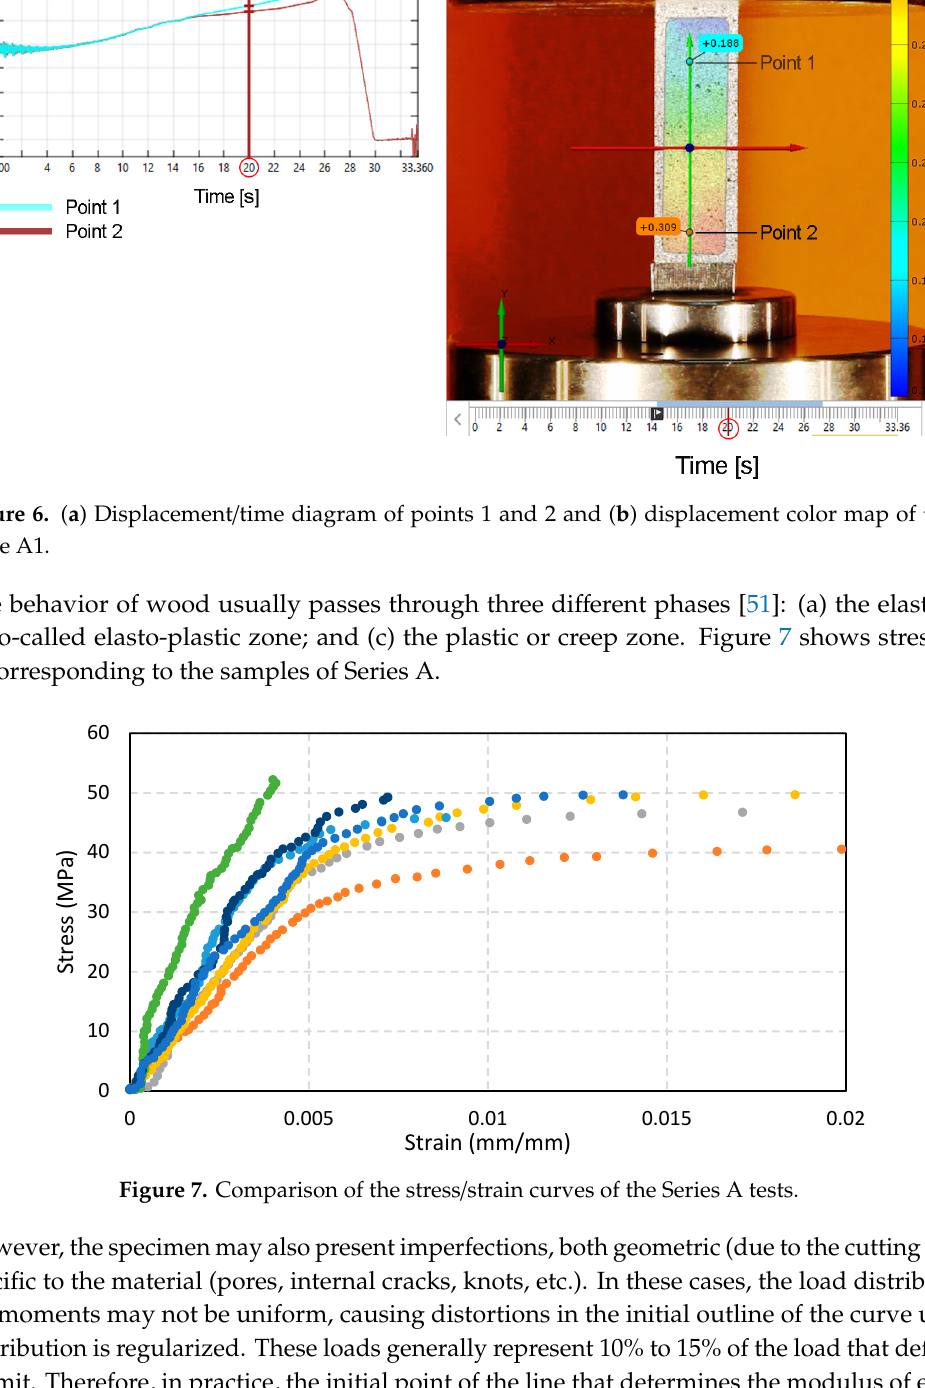
Figure 6. ( a ) Displacement/time diagram of points 1 and 2 and ( b ) displacement color map of test piece A1.